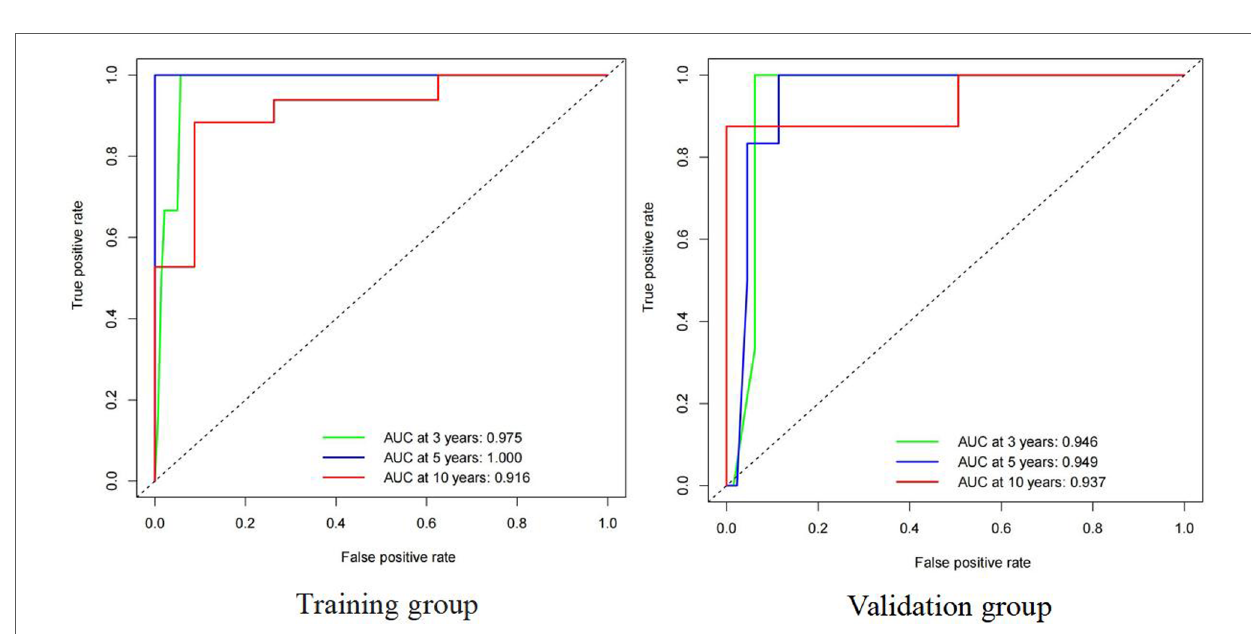
FIGURE 5 Time-dependent receiver operating characteristic (ROC) curve for cause-speci fi c survival nomogram in TETs of training group ang validation